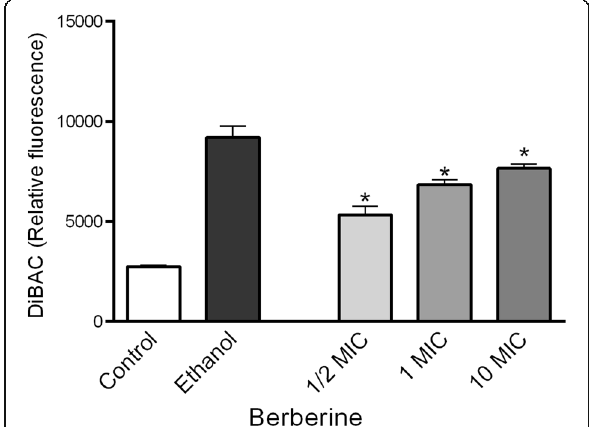
Fig. 6 The effect of different berberine concentrations on membrane depolarisation of C. albicans cells as a measure of membrane damage and cell viability. The data are shown as means ± SDs